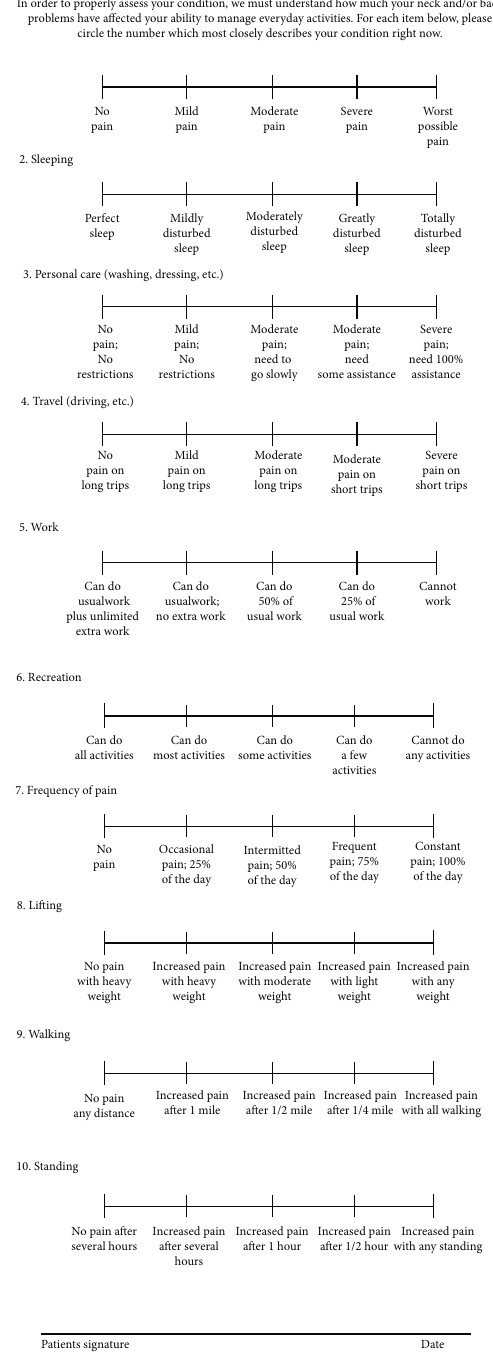
Figure 1: Functional Rating Index-English (FRI-En) Figure 1 (FRI-English version)). Like the original version, the FRI-Ar version (see Figure 2 (FRI-Arabic version))